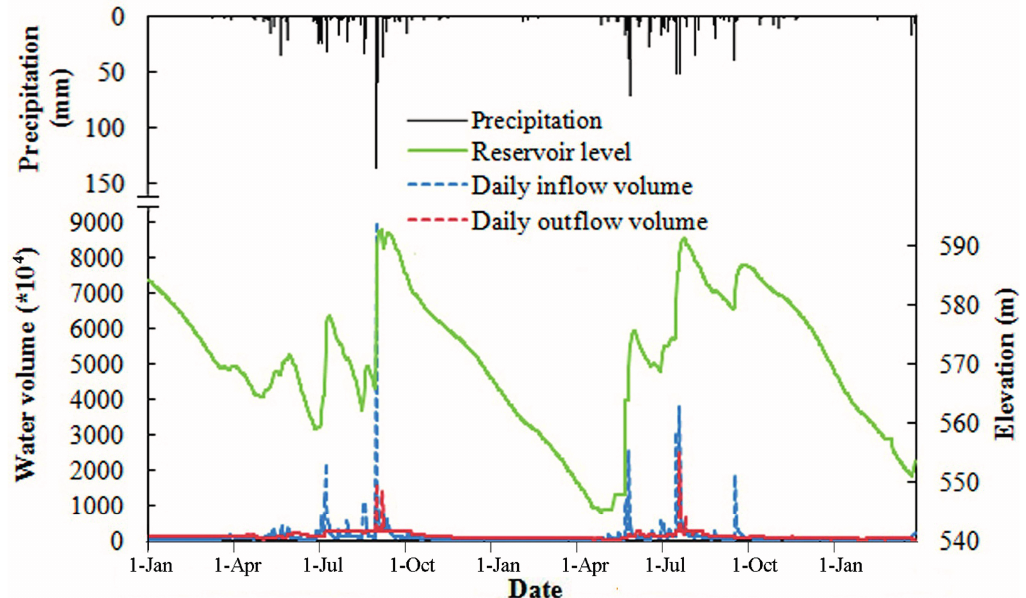
Figure 3. Variations in daily precipitation, inflow volume, outflow volume, and water level in the Heihe Reservoir from 1 January 2012 to 31 March